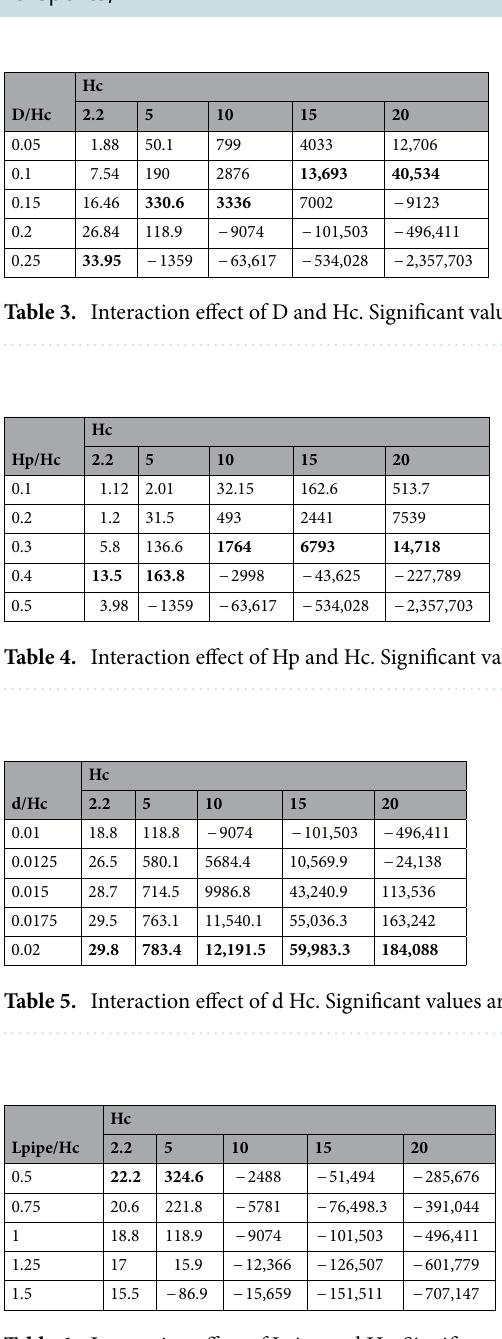
Table 6. Interaction effect of Lpipe and Hc. Significant values are in bold.